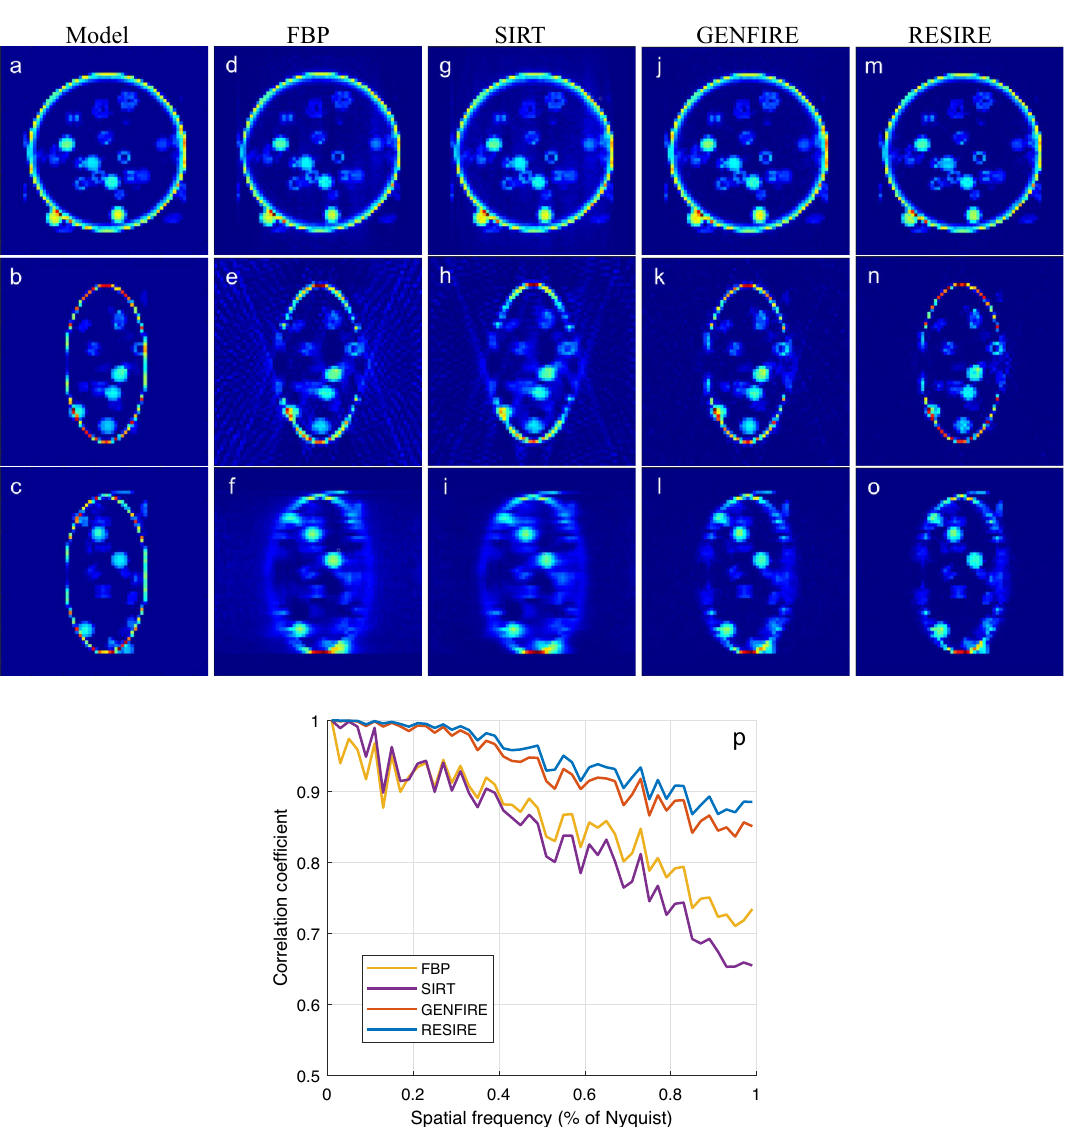
Figure 2. 3D reconstruction of a simulated biological vesicle. ( a – c ) Three 10-voxel-thick central slices of the vesicle model in the XY, XZ and YZ planes, respectively. The corresponding three reconstructed slices with FBP ( d – f ), SIRT ( g – i ), GENFIRE ( j – l ), and RESIRE ( m – o ), where the missing wedge direction is along the z-axis. ( p ) The FSC between the model and the reconstructions showing that RESIRE produces a better reconstruction than FBP, SIRT, and GENFIRE at all spatial